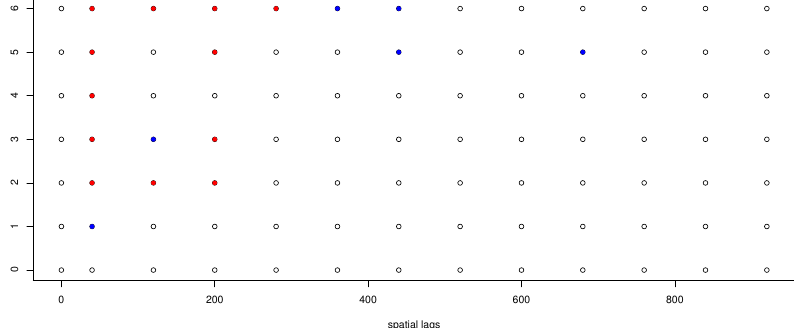
Figure 9. Highly significant spatio-temporal atypical lags (in red) and doubtfully significant (in blue) of the daily Tmax from the NOAA